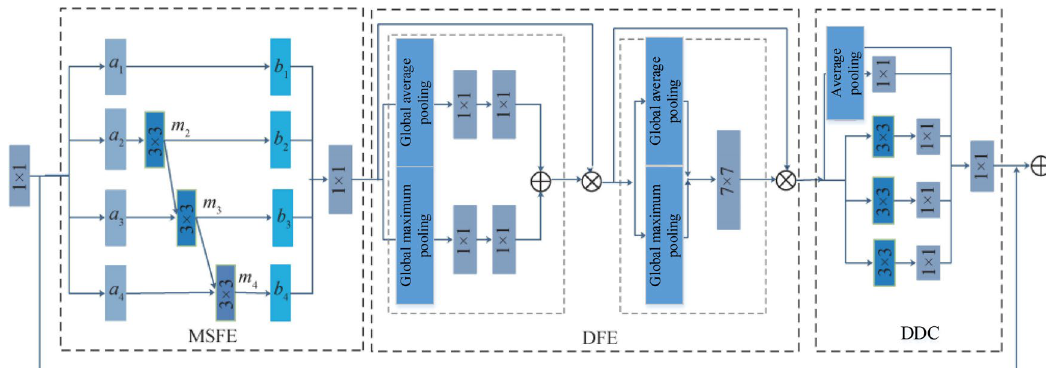
Fig. 7 Detailed bottleneck structure